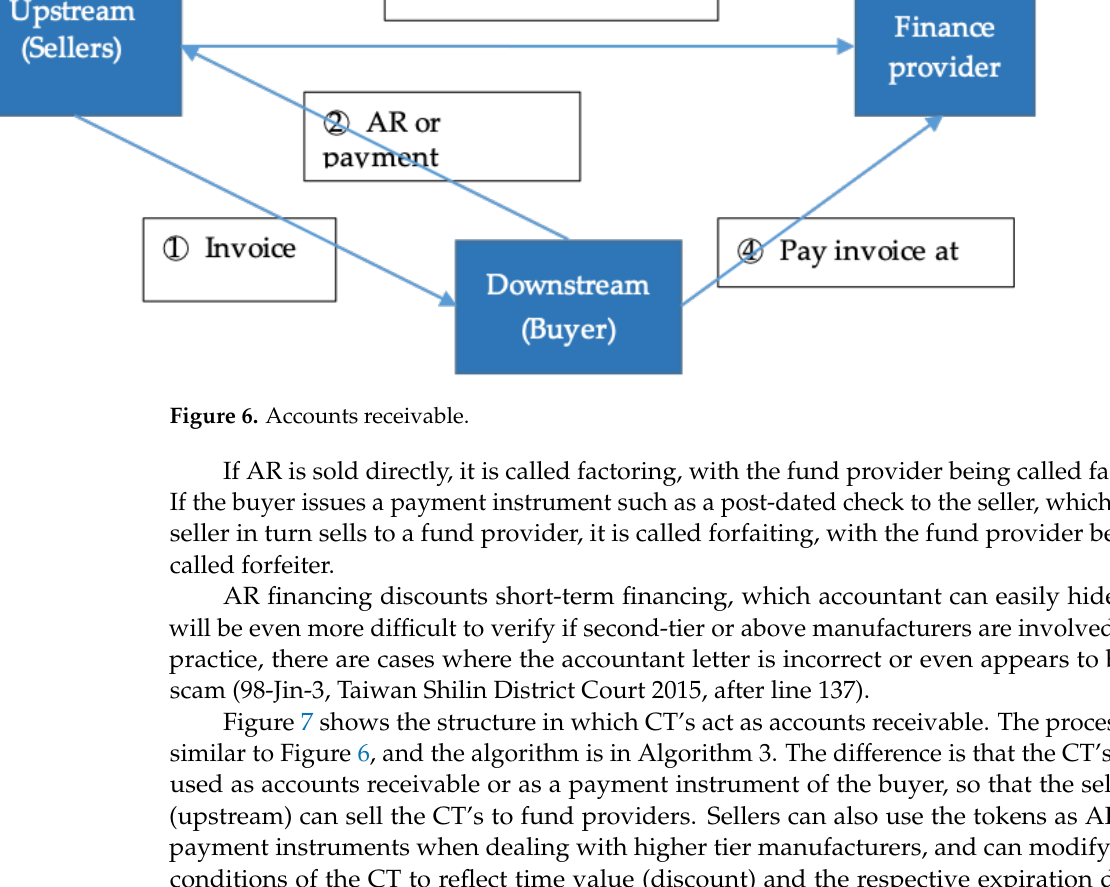
Algorithm 2 The processes and the operations of inventory financing